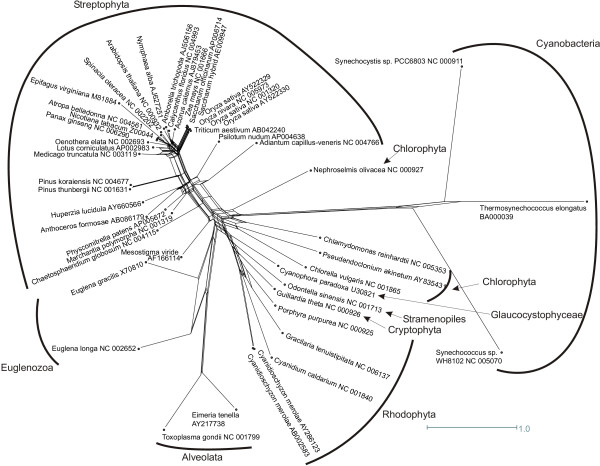
Neighbor-net reconstruction based on GBDP distances between whole plastid genomes. The GBDP variant used was based on equations (2) and (6) as well as BLASTN HSP search. In case of asymmetric distances, the minimum value was taken. This distance matrix achieved the globally highest c-score (0.8298), i.e., highest phylogenetic accuracy according to our reference topology, with BIONJ as tree reconstruction method. The matrix' δ value was 0.2013, pointing to fairly high distance quality. Bacterial outgroup taxa and major eukaryotic groups are indicated. Resolution is much higher than in best results obtained with mitochondrial genomes (Fig. 3), and most major eukaryotic groups are recovered.